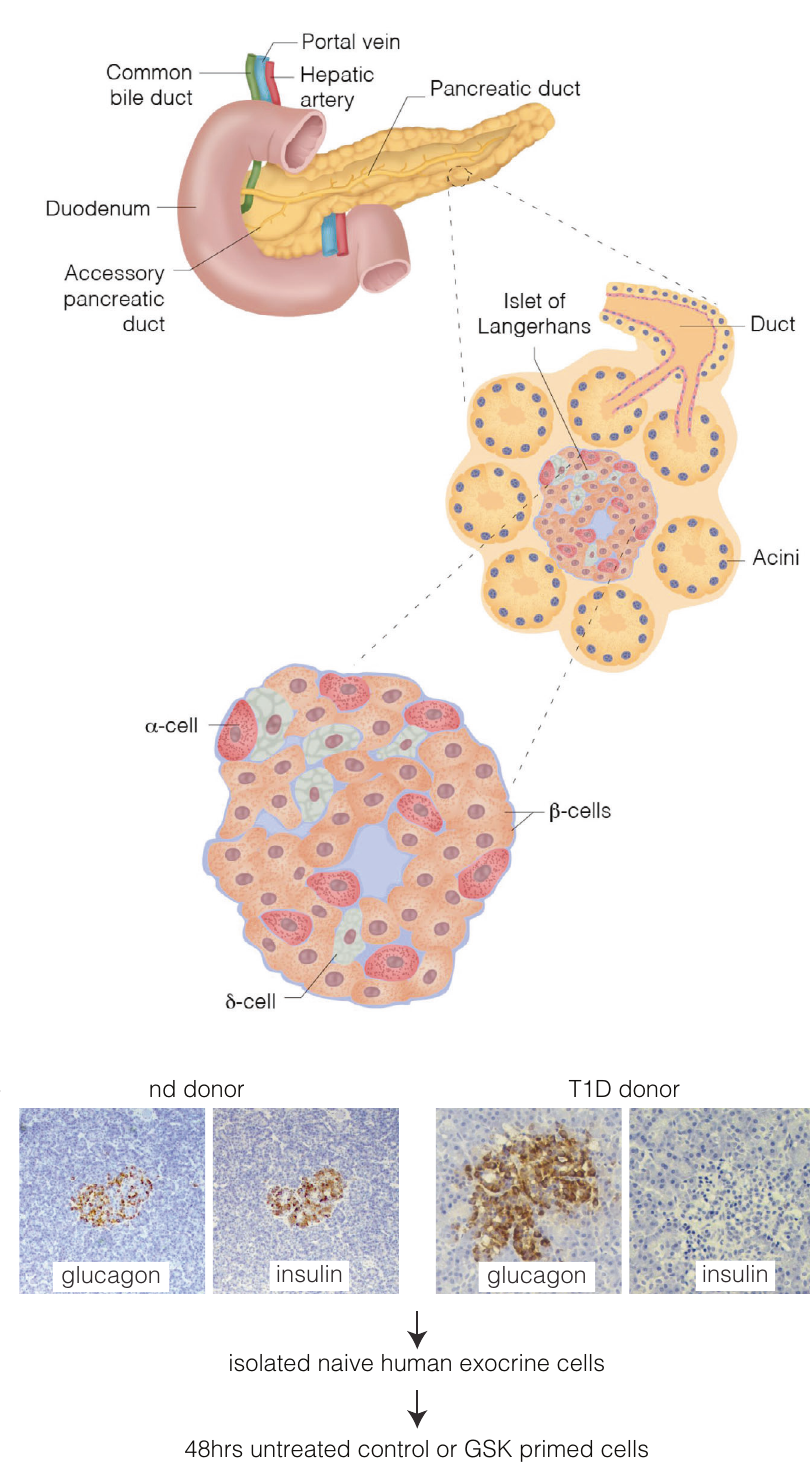
Fig. 1 Human cadaveric ex vivo exocrine isolation. a Schematic of the human pancreas emphasising the ductal endocrine and exocrine organisation. Pancreatic islet illustrated showing the major cell types. Pancreatic exocrine cells were isolated from cadaveric tissue derived from two non-diabetic and a T1D donor. b Representative immunohistochemical insulin and glucagon staining in the non-diabetic donor and T1D donor. Insulin and glucagon expression are indicated by the brown staining in human islets. Note the complete absence of insulin in